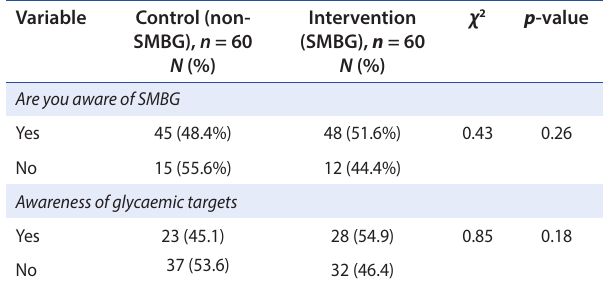
Table 2: Awareness of SMBG and glycaemic targets